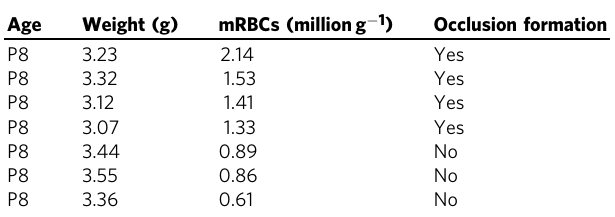
Table 1 Relationship between the injected amount of mRBCs and vascular occlusion